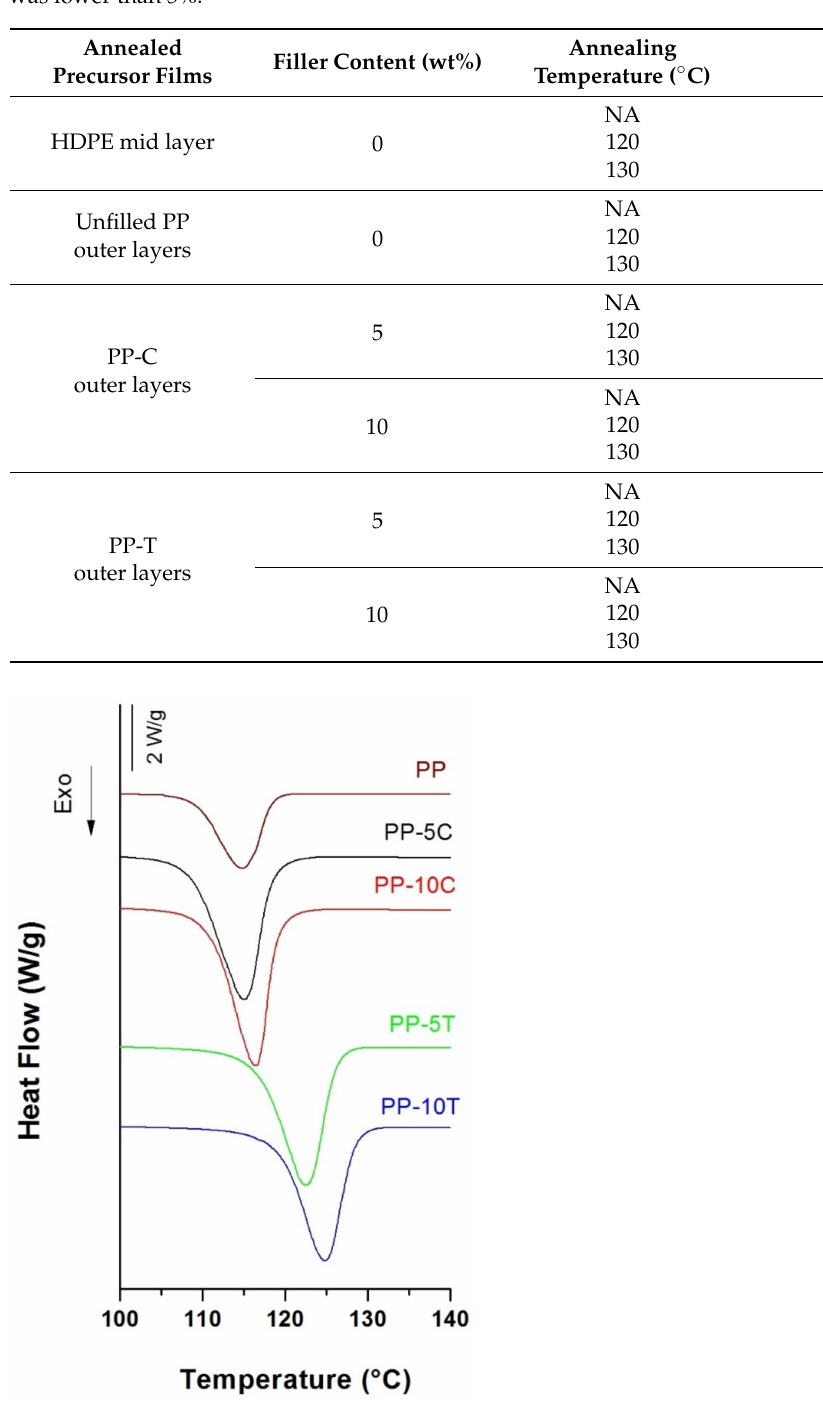
Table 1. Crystalline orientation function (F c ) for polypropylene (PP) and high-density polyethylene (HDPE) layers in annealed and non-annealed (NA) precursor films. PP-C and PP-T stands for polypropylene outer layers containing calcium carbonate and talc respectively. Standard deviation was lower than 5%.